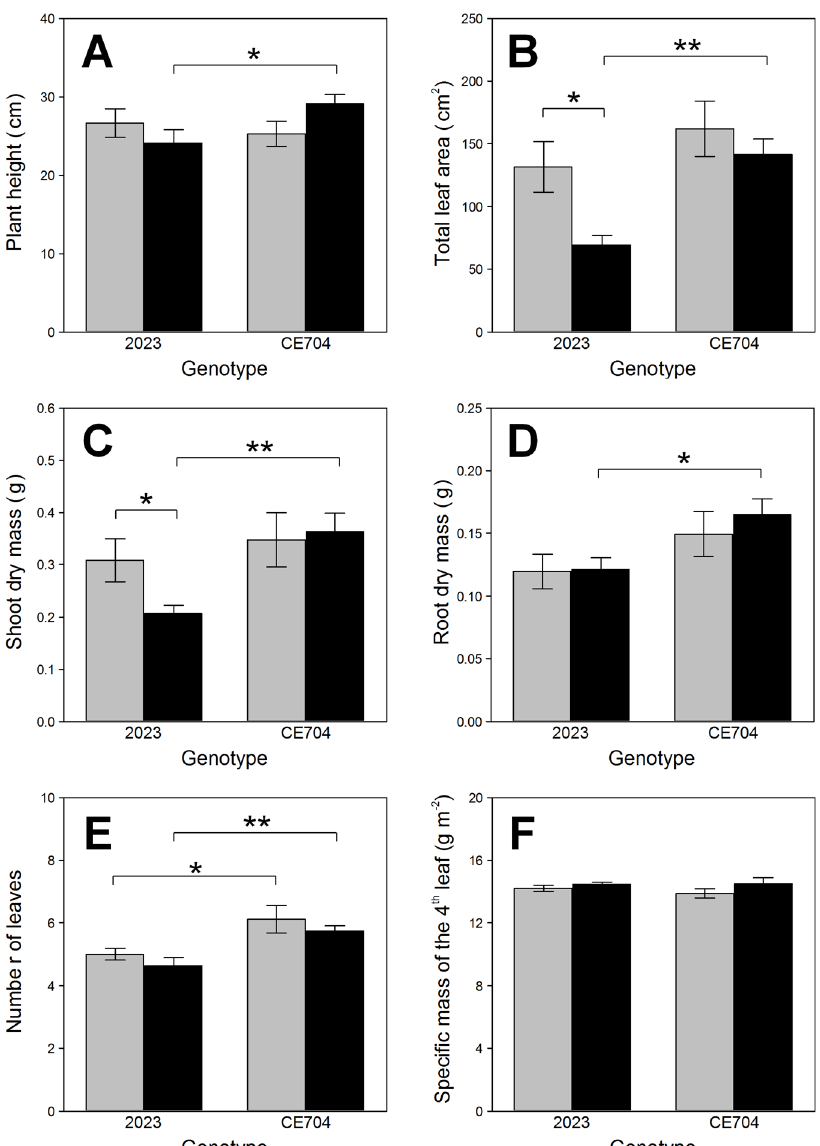
Fig 2. Selected parameters of plant morphology in two maize genotypes (2023 and CE704). Plants were either subjected to normal watering (control; grey columns) or to 14 days of withholding water (stress; black columns). Mean values ± SEM are shown (n = 8). Asterisks indicate significant ( p (cid:20) 0.05; (cid:3) ) or highly significant ( p (cid:20) 0.01; (cid:3)(cid:3) ) differences between mean values according to Tukey’s tests made separately for each genotype (in case of the differences between control and stress treatment) or for each treatment (in case of the differences between both